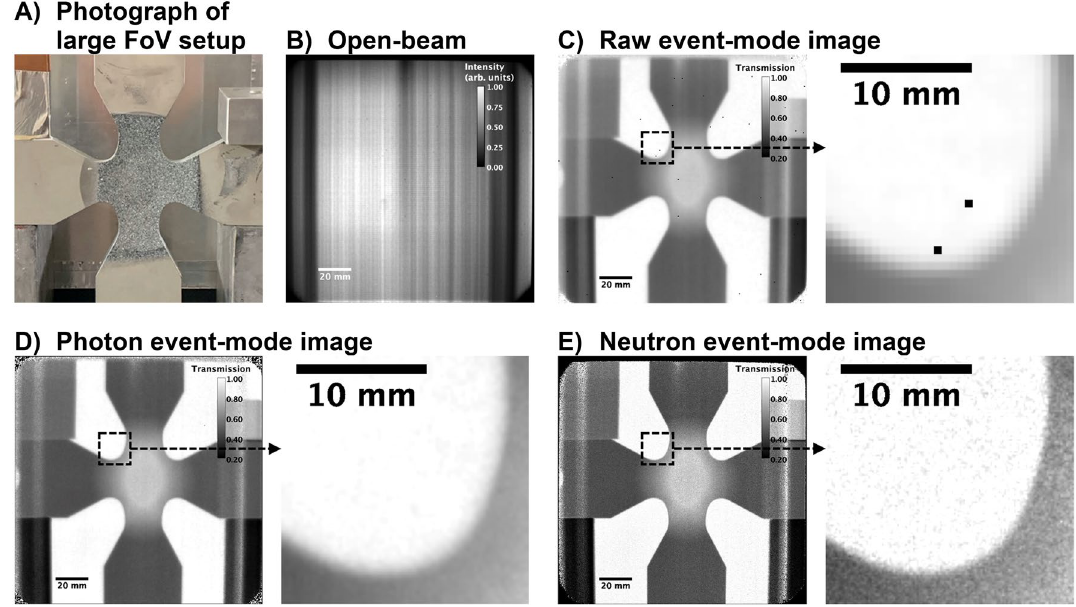
Figure 3. Photograph of various objects positioned at 10 cm distance to the scintillator in ( A ) (steel cross in the center, lead bricks on the bottom left and right, copper sheets on the top left and aluminum cube on the top right). Open-beam using CoM neutron events at sub-pixel resolution of ¼ pixel-pitch in ( B ). Normalized radiographs, including an enlarged section of ~ 2 × 2 cm 2 , produced from: raw event data using the native resolution of the chip in ( C ); CoM photon events at sub-pixel resolution of ½ pixel-pitch in ( D ); CoM neutron events at sub-pixel resolution of ¼ pixel-pitch in ( E